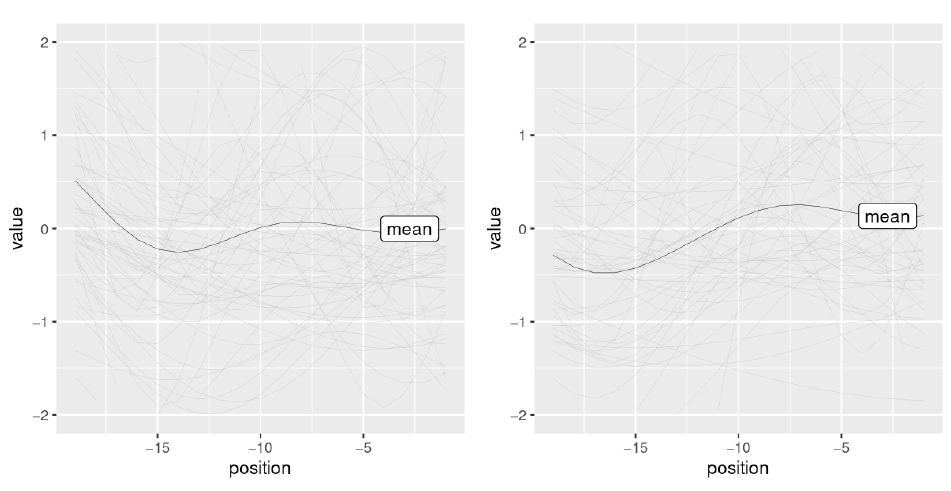
Figure 7. Fitted sinusoidal curves for the pre-peak regions, within a window of 19 frames. The thick lines in the center show the mean